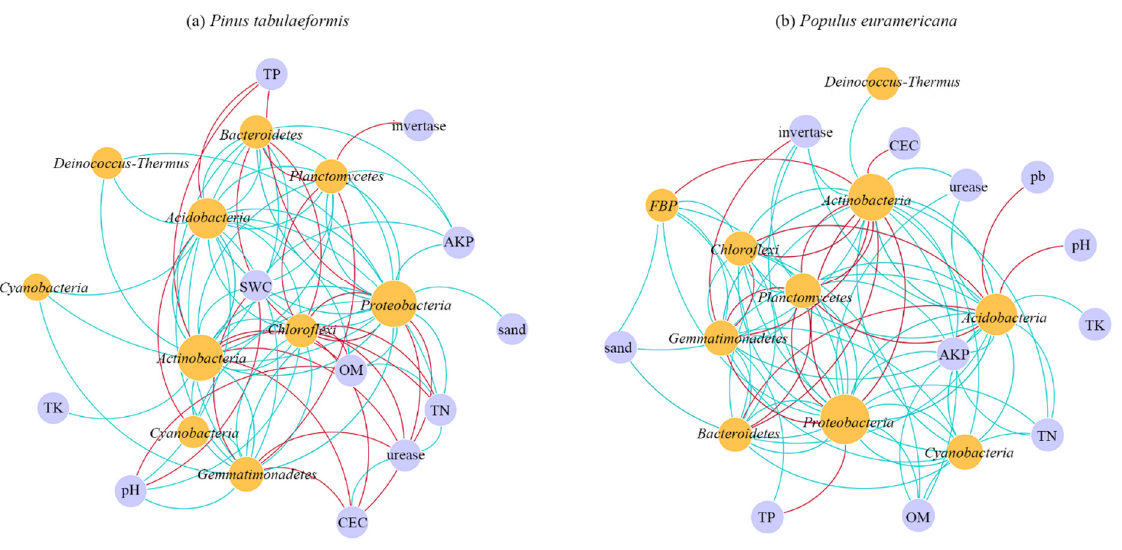
Figure 8. RDA analysis of environmental factors and major bacteria in the Heidaigou open-pit coal mine dump and control area. Note: AKP, soil alkaline phosphatase activity; CEC, soil cation exchange capacity; pH, soil pH; TK, soil total potassium; TN, soil total nitrogen; TP, soil total phosphorus; and WC, soil water content.